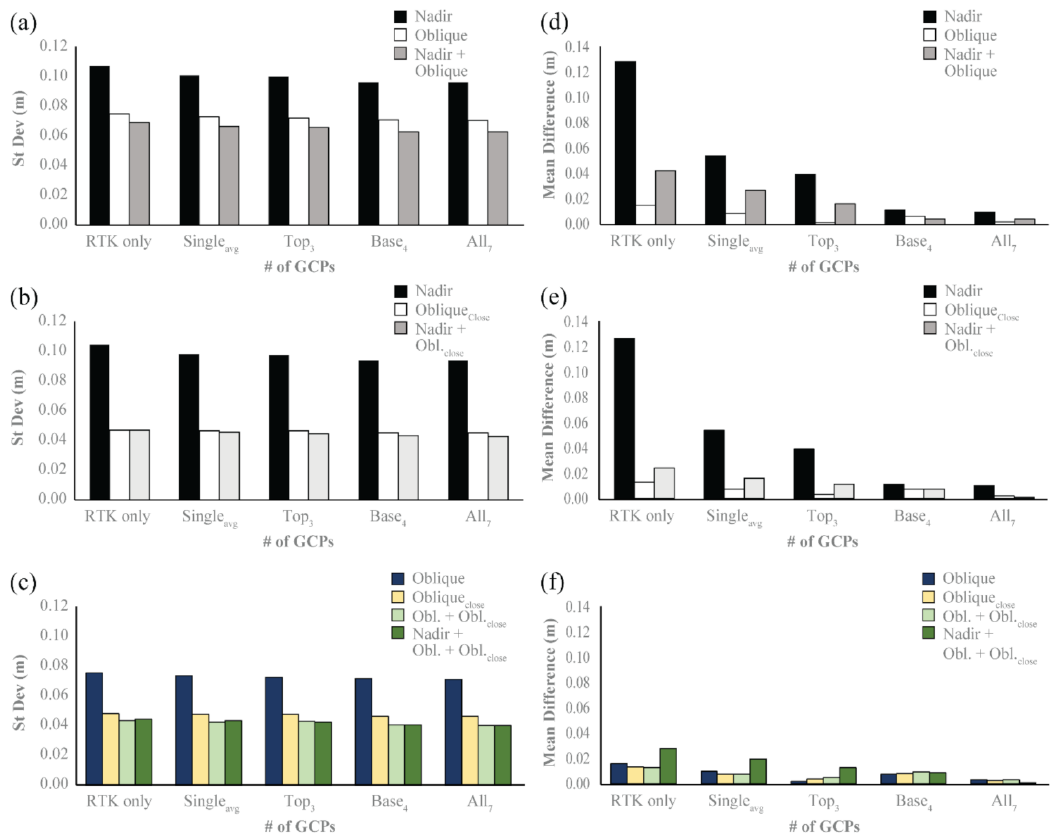
Figure 5. M3C2 error statistics grouped by georeferencing strategy and subgroups of imaging strategy. Standard deviations: ( a ) Nadir + Oblique, ( b ) Nadir + Oblique close , ( c ) Oblique + Oblique close and Nadir + Oblique + Oblique close ; mean error: ( d ) Nadir + Oblique, ( e ) Nadir + Oblique close , ( f ) Oblique + Oblique close and Nadir + Oblique + Oblique close . ‘Obl.’ refers to ‘Oblique’.